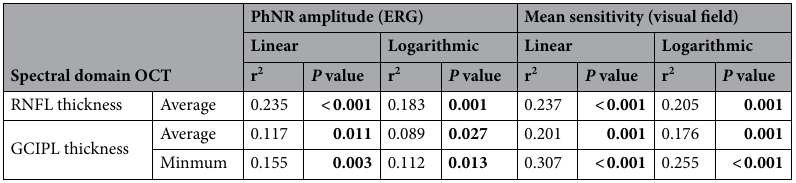
Table 3. The relationship between mean retinal nerve fiber layer (RNFL) or ganglion cell-inner plexiform layer (GCIPL) thickness and photopic negative response (PhNR) or mean sensitivity of standard automated perimetry in patients with glaucoma or suspected glaucoma. ERG, electroretinogram; GCIPL, Ganglion cell- inner plexiform layer; OCT, optical coherence tomography; PhNR, photopic negative response; RNFL, retinal nerve fiber layer. Statistically significant values ( P < 0.05) are in bold.